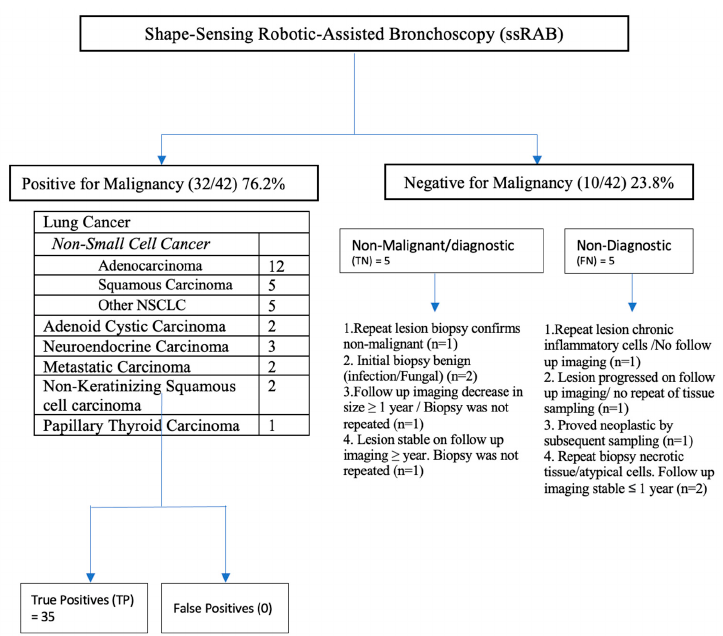
Figure 4. Algorithm describing diagnostic results to determine diagnostic outcomes in subjects undergoing robotic-assisted bronchoscopy lesion biopsy. Positive malignancy test results were considered positive pathologic results. For this 12-month follow-up study, pathology results that were negative for malignancy or indeterminate were referred to as negative for malignancy. These patients who had either repeat sampling confirming benign pathology or follow-up imaging showing no progression and were considered to be true negatives at 12 months. Cases that were negative and repeat sampling showed malignant pathology were considered to be false negatives at 12 months. One case was deferred in the primary analysis of the 12-month yield because of increased lesion size and no subsequent sampling because the patient refused. Table 2. Twelve-month outcomes.